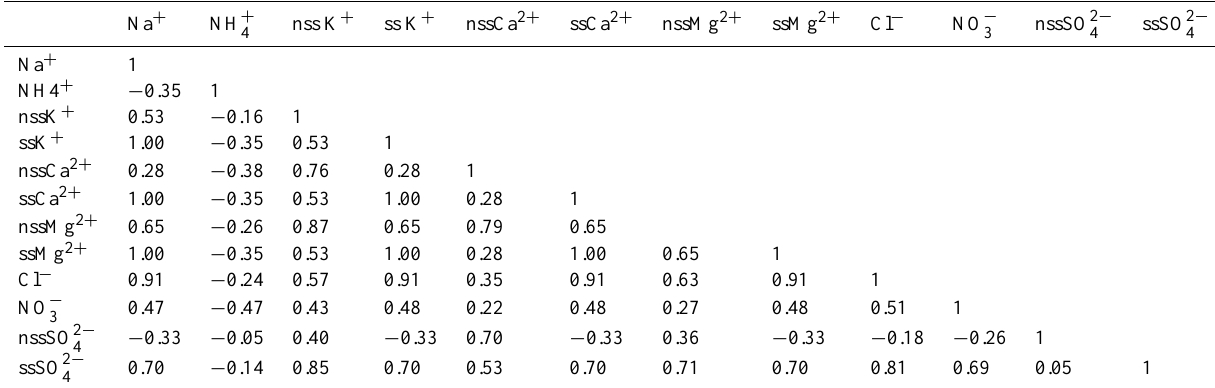
Table 5. Correlation coefficients ( r ) of major ions in spring aerosols from Cape Hedo, Okinawa. Na